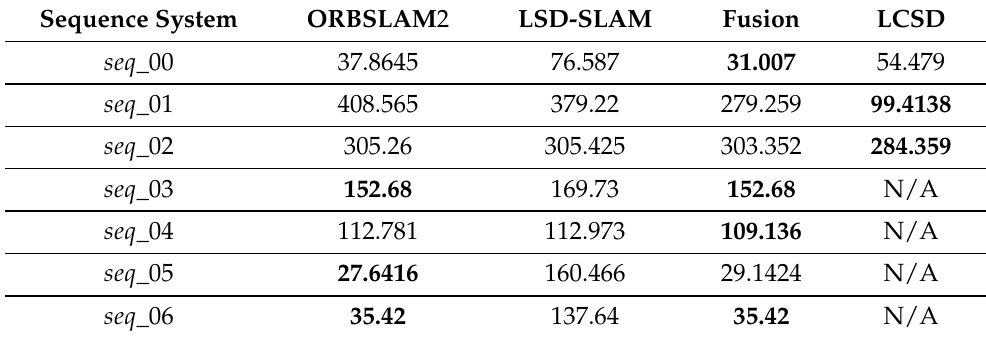
Table 2. RMSE of the four systems on sequences of the KITTI database (best results in bold). The values represent the mean over five passes of each algorithm.